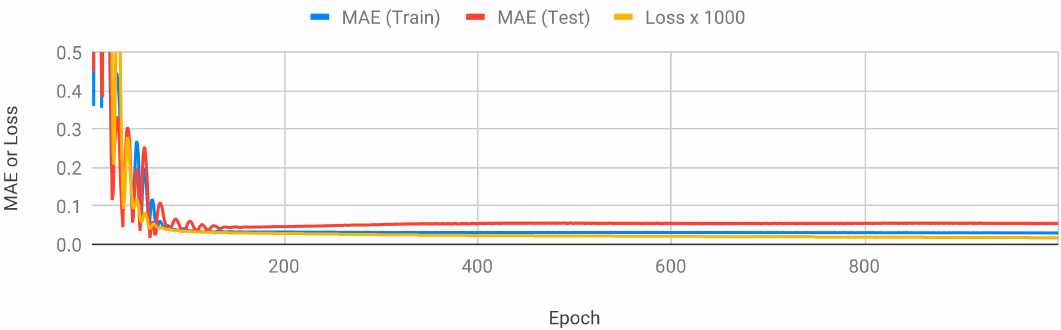
Figure 6. MAE and loss values of RNN.